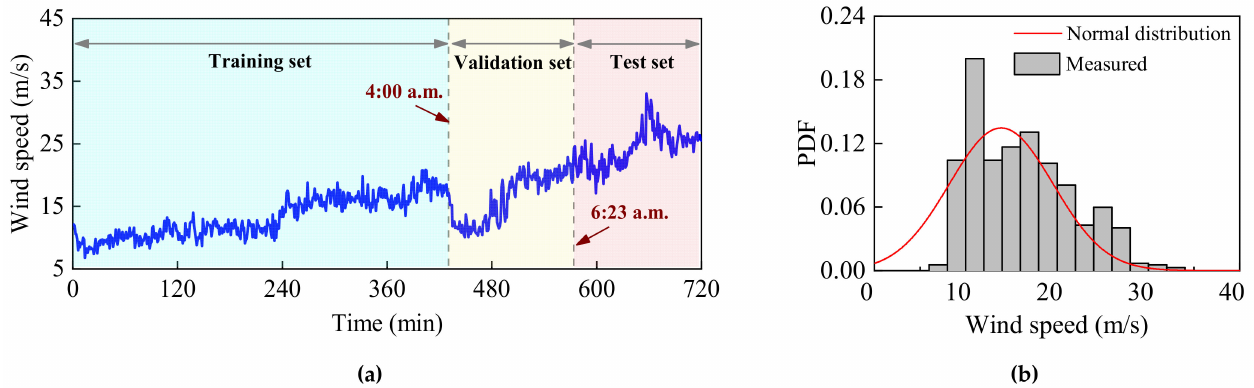
Figure 4. Measured wind speed data. ( a ) Peak wind speed in a 1 min time interval; ( b ) PDF of measured wind